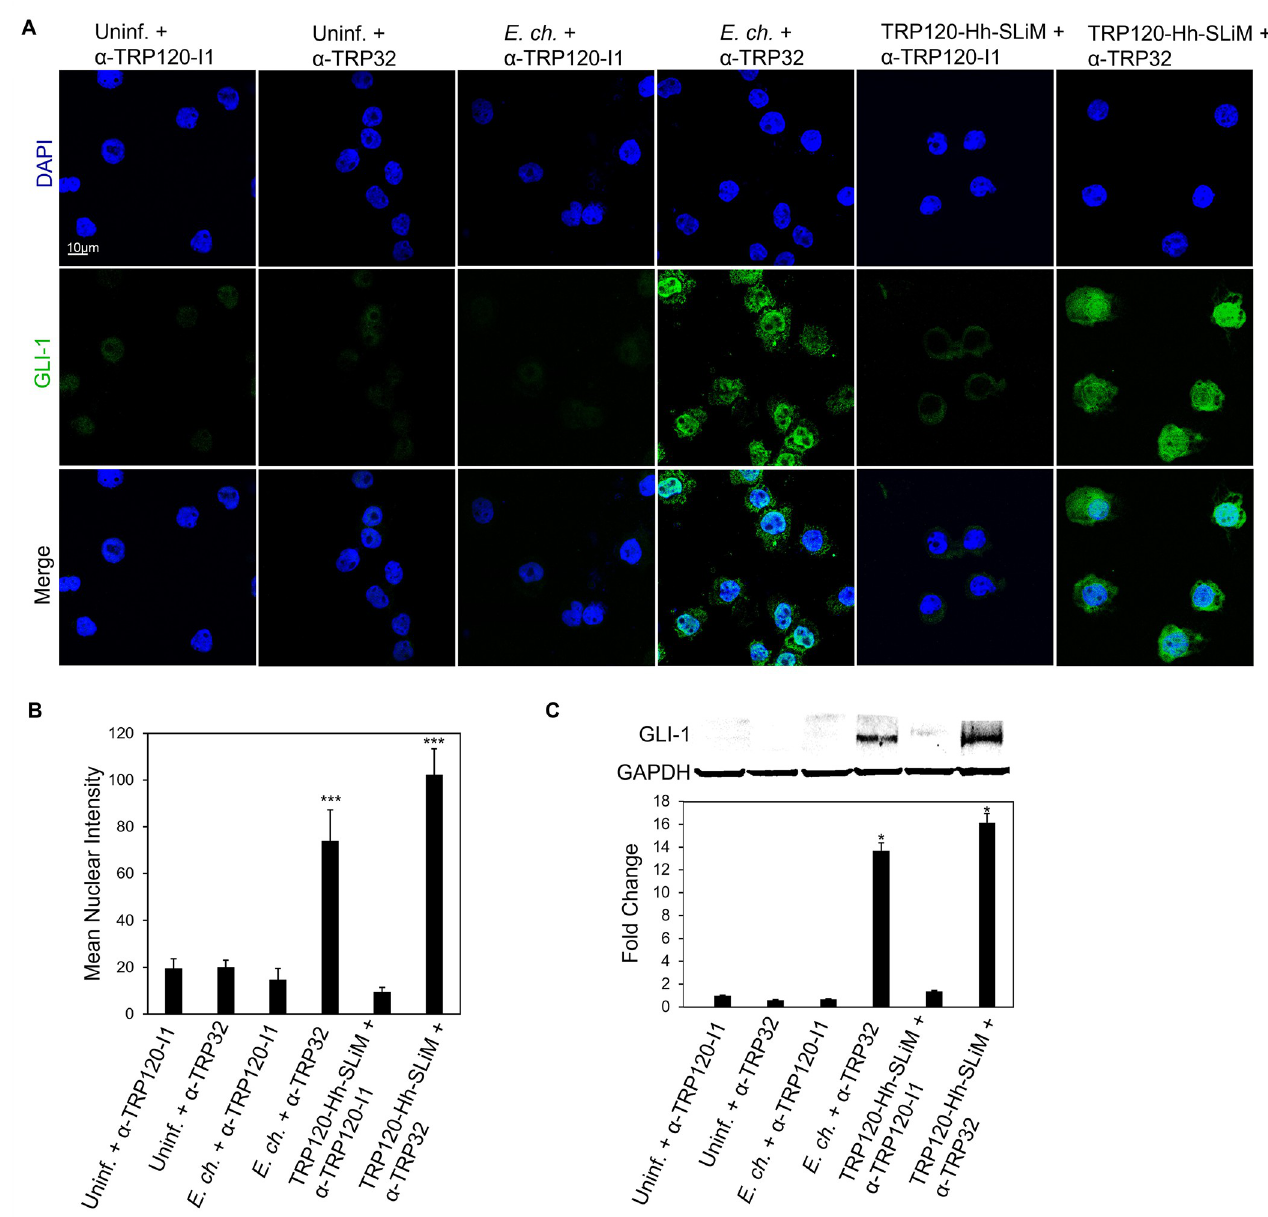
Fig 9. Anti-TRP120-Hh-SLiM antibody blocks Hh signaling and GLI-1 nuclear translocation. (A) E . chaffeensis (MOI 100) and SLiMs were incubated with α -TRP120-I1 (targets TRP120 sequence SKVEQEETNPEVLIKDLQDVAS) or α -TRP32 (neg ctrl) (1.5 μ g/mL) for 1 h or overnight, respectively, before incubation with THP-1 cells. THP-1 cells were harvested at 10 hpt, immunostained with GLI-1 (green), and visualized by confocal fluorescence microscopy. Scale bar = 10 μ m. 10 randomized areas/slide were used to detect GLI-1 nuclear translocation. (B) Intensity graph demonstrates the mean nuclear accumulation of GLI-1 in respective THP-1 cells. Analysis was performed using ImageJ and determining mean grey value from randomized areas/slide (n = 10). (C) Western blot analysis of treatment groups with GAPDH as a loading control. Data are represented as means ± SD ( � p < 0.05). (A-B); α -TRP120-I1 inhibits GLI-1 upregulation in cells with E . chaffeensis or TRP120-Hh-SLiM compared to α -TRP32. Untreated cells were incubated with α -TRP120-I1 or α - TRP32 as negative controls. Experiments were performed with at least three biological and technical replicates and significance was determined through t -test analysis. Randomized areas/slide (n = 10) were used to detect GLI-1 nuclear translocation.